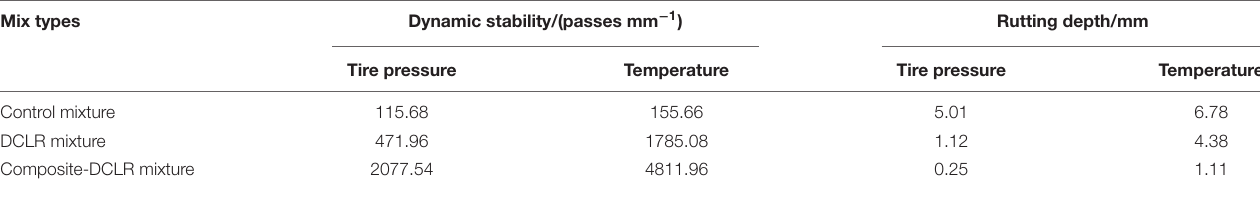
TABLE 3 | Value range analysis of three asphalt